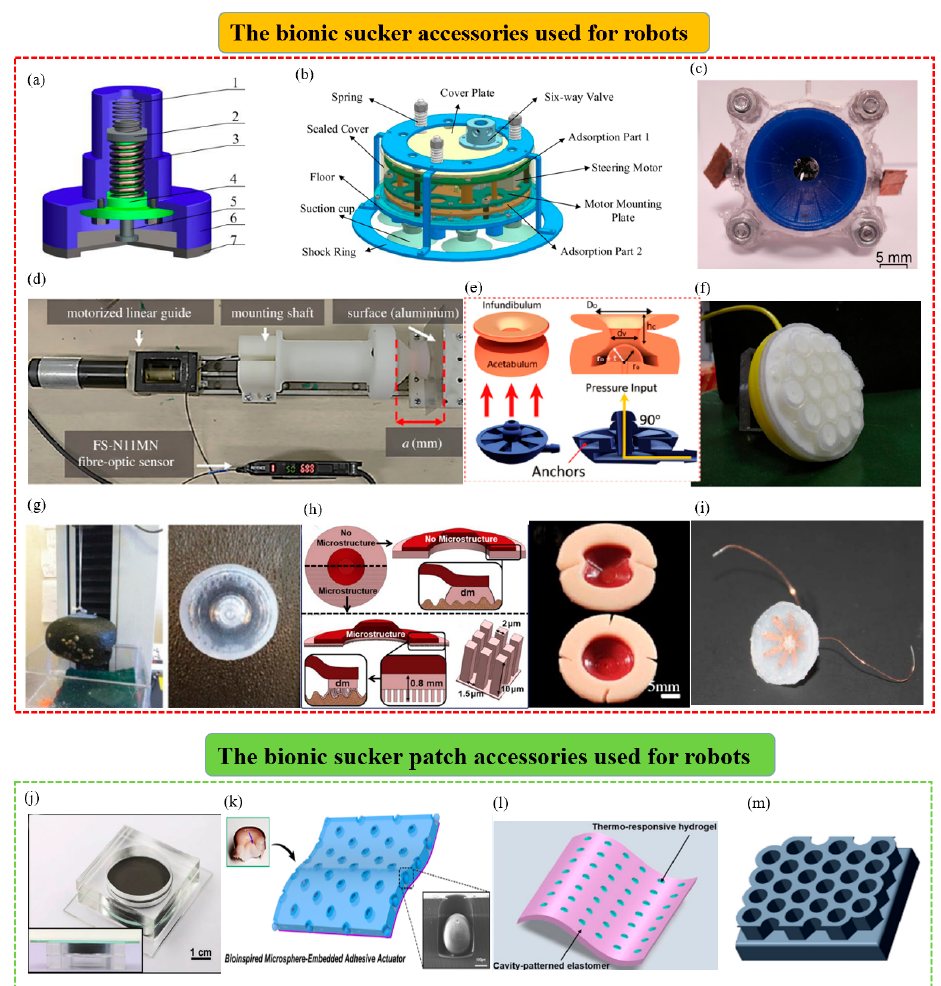
Figure 6. Bionic suction cups used as robot accessories. ( a ) A bioinspired miniature suction cup